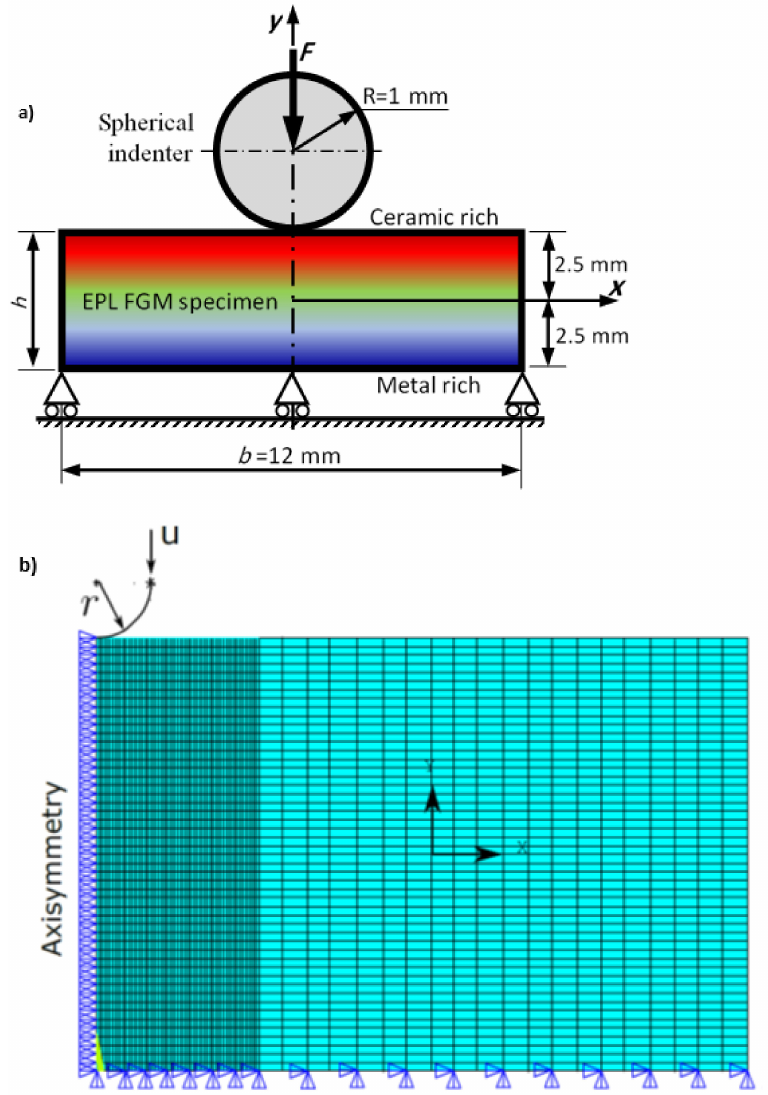
Figure 3. Schematic representation of the spherical indentation of an elastoplastic FGM specimen. ( a ) Representation of the spherical indentation problem ( b ) Presentation of boundary condition and